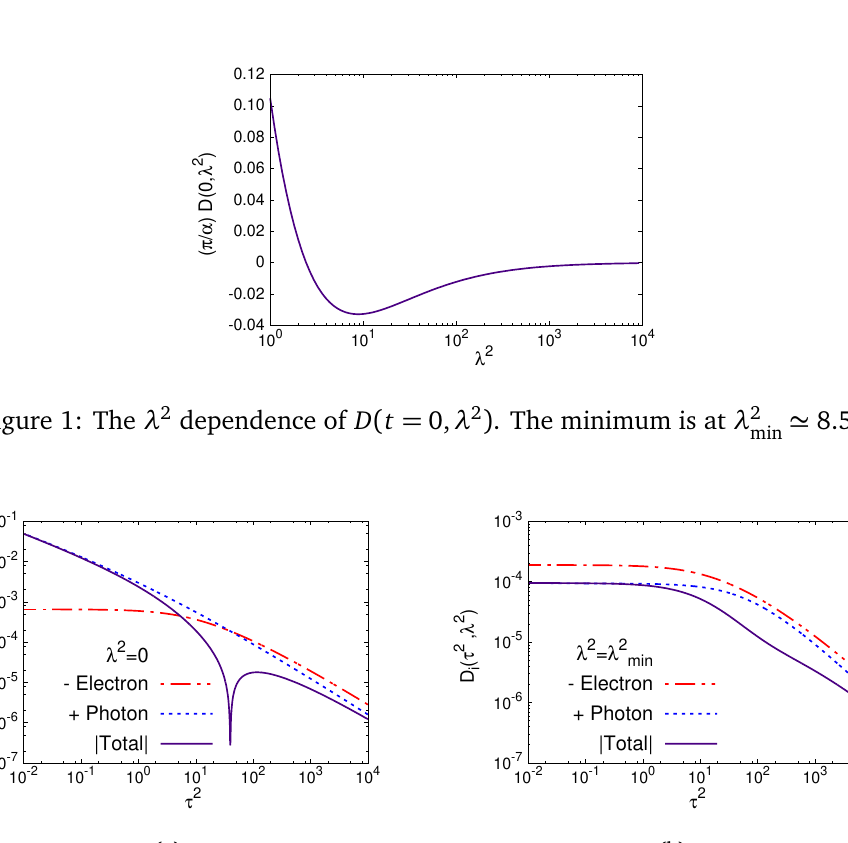
Figure 2: The form factor D ( τ 2 , λ 2 ) as a function of τ 2 , for λ 2 = 0 (left) and for λ 2 = λ 2 (right). The blue dotted (red dash-dotted) curves correspond to the photon min (electron) contributions. The absolute value of the total form factor is shown as the solid purple